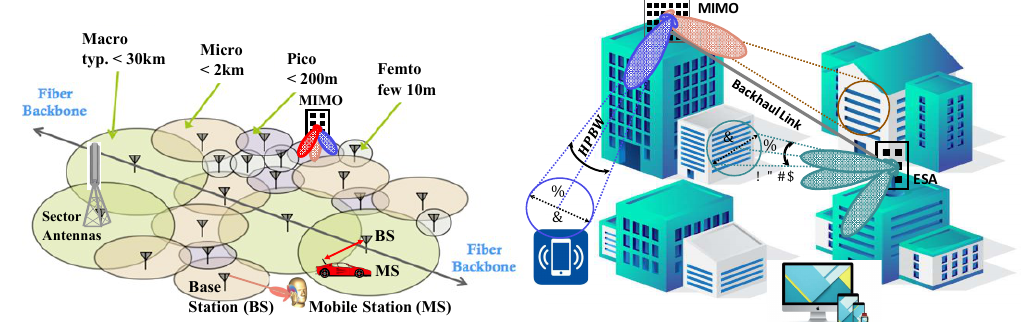
Figure 2. 5G network architecture ( left ). Coverage (footprint) of Electronically Steerable Antennas (ESAs) and multi-beam antennas at certain distance d , resulting in an area diameter of 𝑎 ≈ 𝑑 ∙ 𝐻𝑃𝐵𝑊 for small 𝐻𝑃𝐵𝑊 ( right ). HPBW: half-power beamwidth.